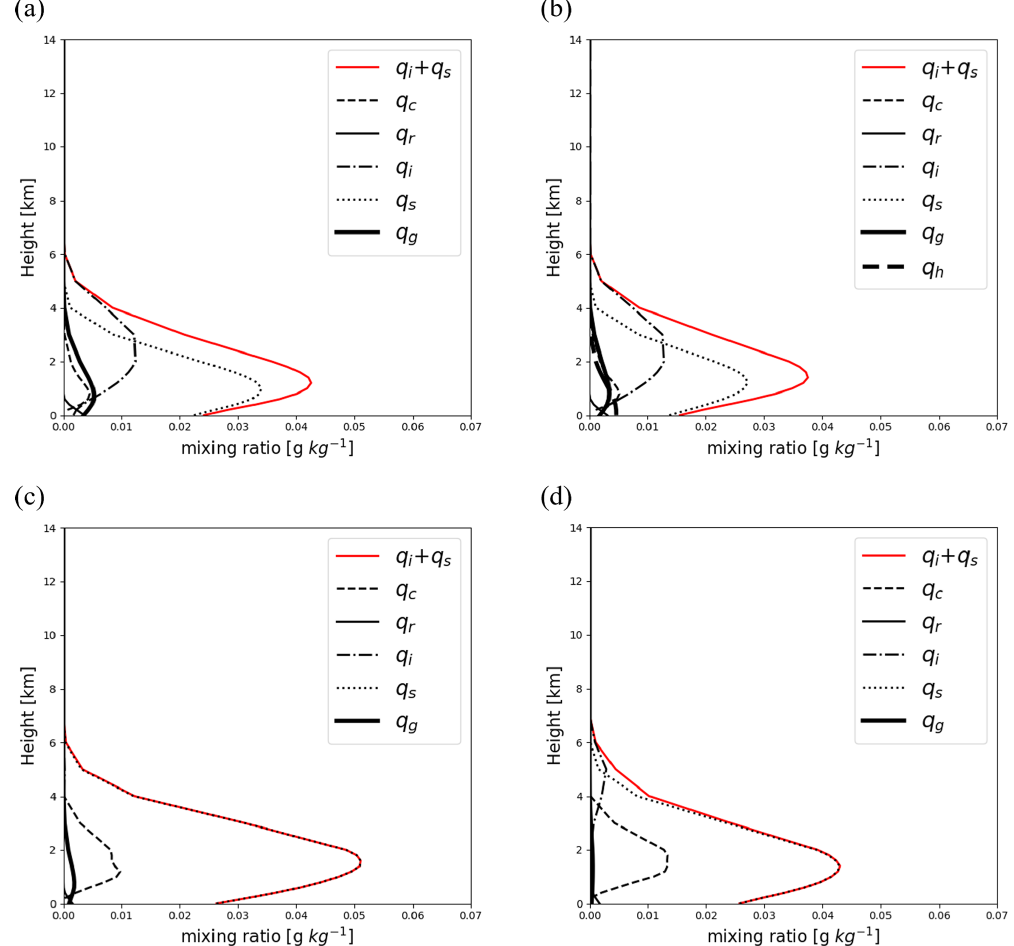
Figure 8. Time-domain-averaged vertical hydrometeor mixing ratio profiles from the simulations using the (a) WDM6, (b) WDM7, (c) Thompson, and (d) Morrison schemes for case 3. The averaged time and domain are the same as that in Fig. 6. The sum of snow and cloud ice mixing ratios is drawn with a red line in all